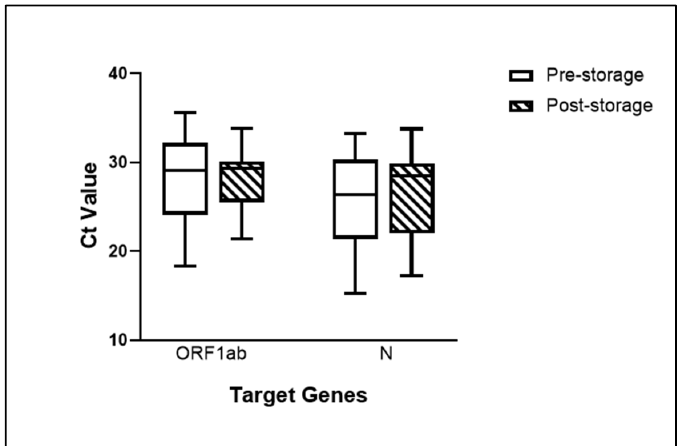
Figure 2. Specimens’ Ct values of targeted genes (ORF1ab and N genes) at pre- and post-storage. The white bars and shaded bars represented Ct value range of pre-storage specimens (detected by the DaAn Gene PCR kit (DaAn Gene, Guangzhou, China)) and post-storage specimens (detected by the XABT Multiple Real-Time PCR Kit of 2019-CoV (Beijing Applied Biological Technologies Co., Ltd., Beijing, China)). Results were interpreted by mean ± SD from 24 specimens.